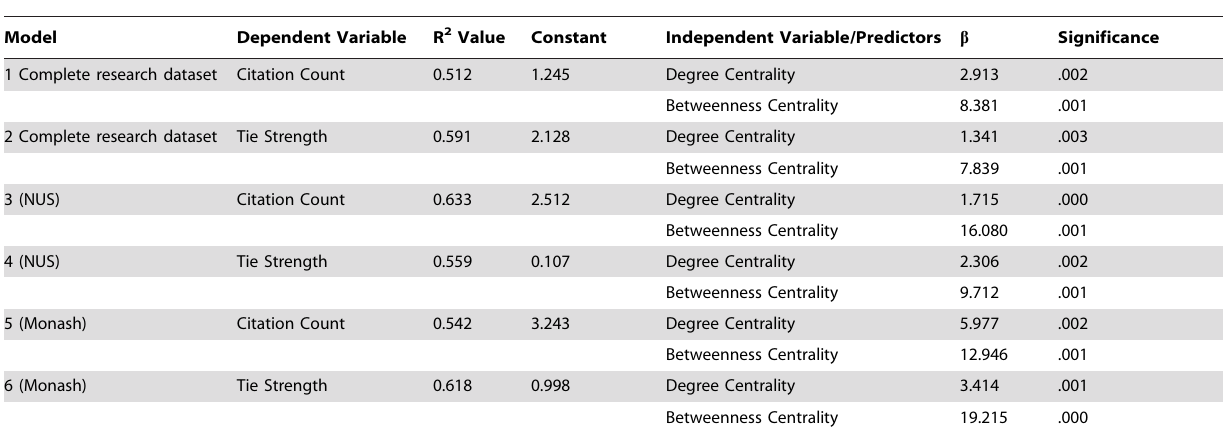
Table 7. Regression models for Complete research dataset, and NUS and Monash University dataset.